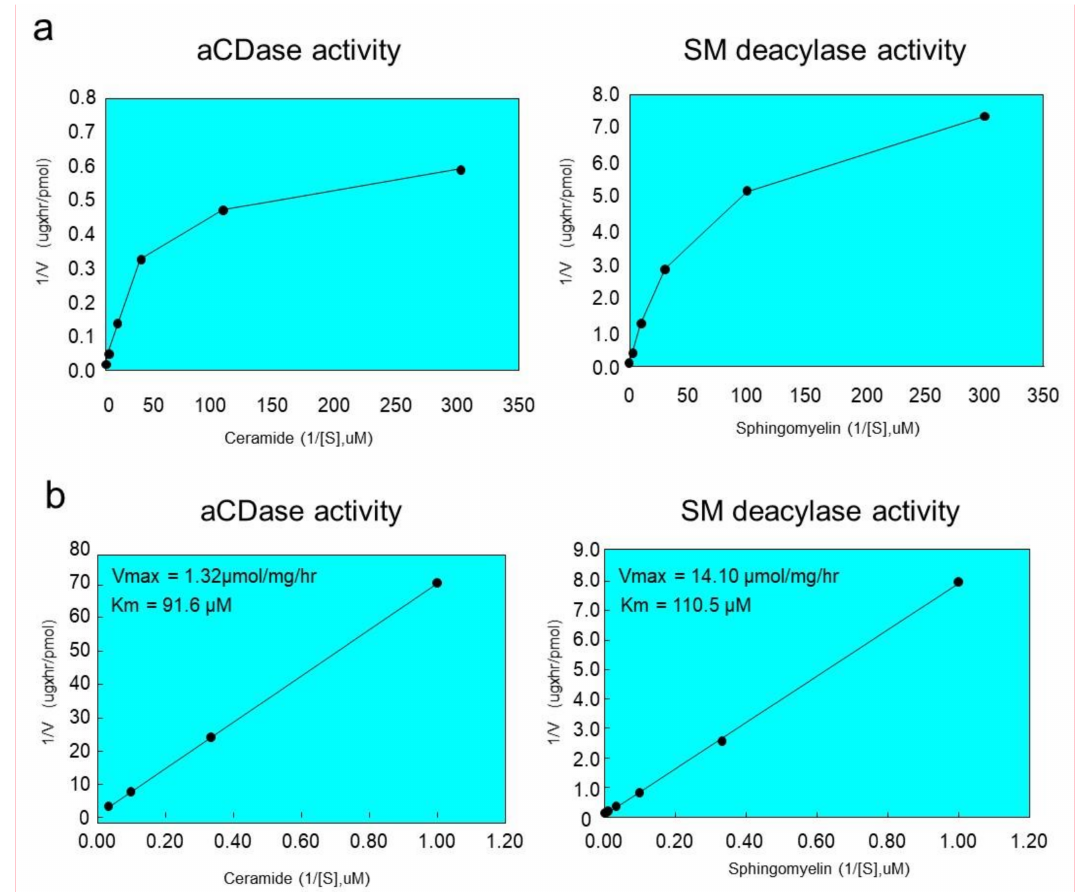
Figure 7. Kinetic analysis of purified rat SM deacylase activity and aCDase activity. ( a ) Purified enzyme was incubated for 12 h at 37 ◦ C with varying amounts of SM or ceramide substrates. The final reaction mixtures contained 50 mM potassium acetate bu ff er (pH 4.7), enzyme source, substrate, 0.1% Triton X-100 and 20 mM CaCl 2 . The rate of SPC or sphingosine (SPH) generation as a function of SM deacylase or aCDase was measured, respectively. ( b ) Lineweaver–Burk plot (double reciprocal) for the reaction: 1 / S (SM or ceramide concentration) versus 1 / V (rate of SPC or SPH formation). The lines represent the data fit for the production of the corresponding products. Results are expressed as means from two separate